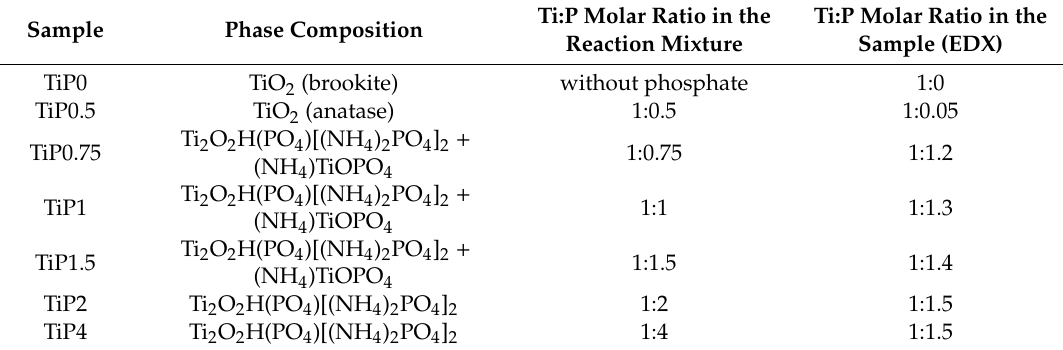
Table 1. The phase compositions and Ti:P molar ratios in the samples prepared by hydrothermally treating the titanium lactate complex at 180 ◦ C in the presence of urea with di ff erent concentrations of phosphate